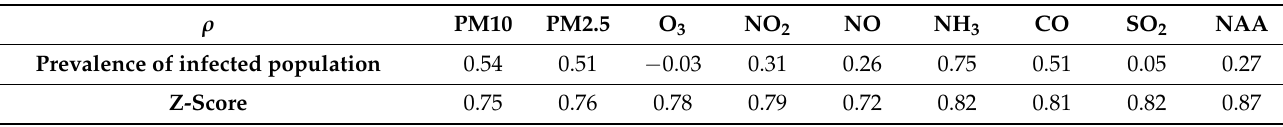
Table 1. Pearson correlation coefficients evaluating the correlation between the prevalence infected population and air pollutants average concentrations, respectively. ρ PM10 Prevalence of infected population